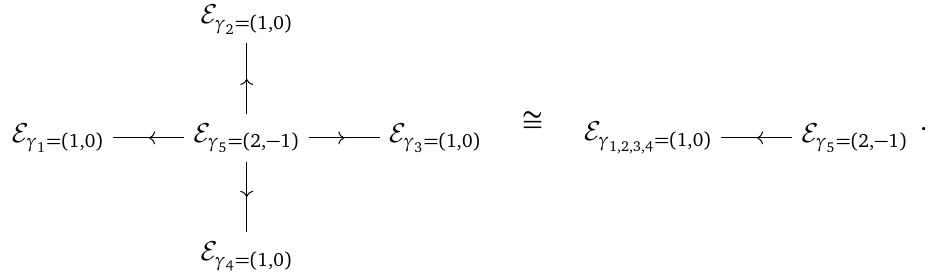
Figure 10: Fundamental domains for SU ( 2 ) N responding to ( I ∗ configuration ( I ∗ the CB configuration ( I ∗ is not modular. The transitions between these configurations can be seen from the fundamental